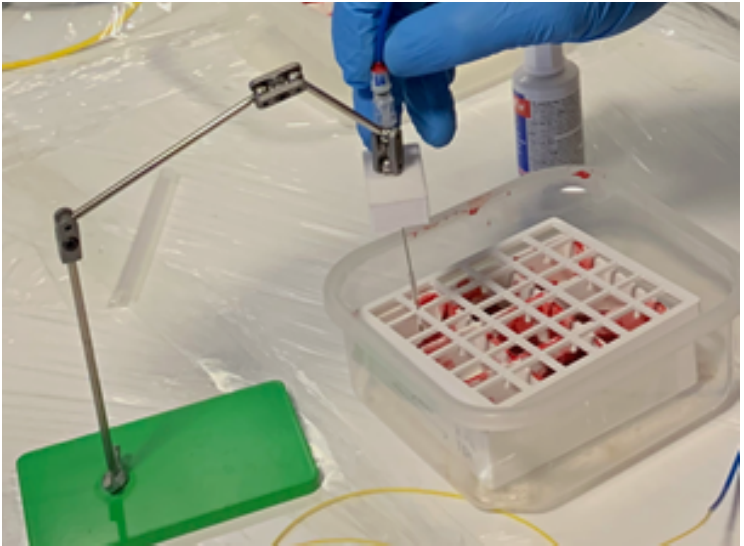
Figure 7. Amniocentesis needle inserted into an ex vivo placenta sample during the placenta heating experiment. The six samples were located inside a white plastic container. The container had a covering designed to support the needle during